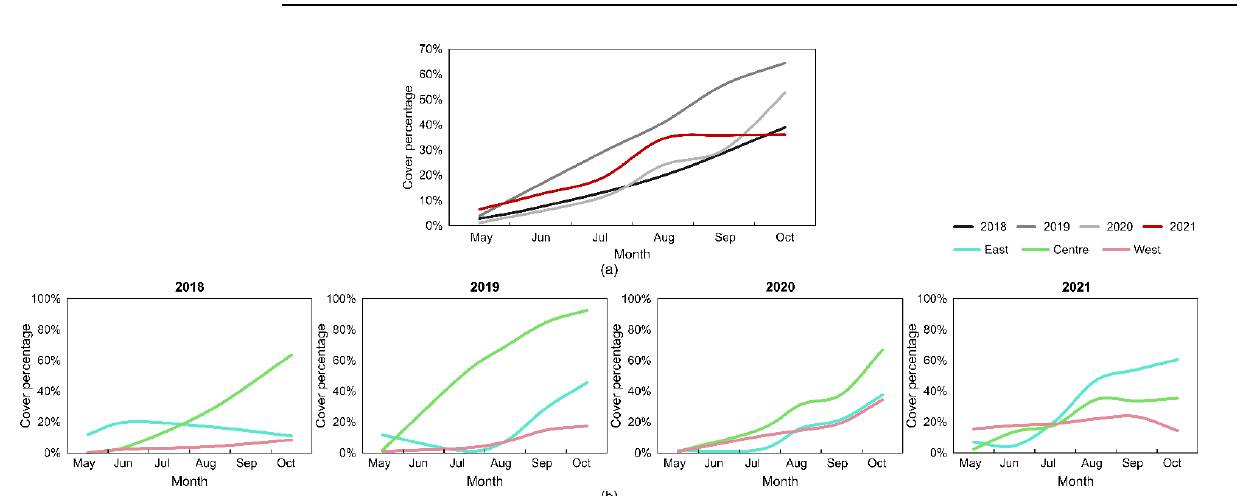
Figure 4. Water hyacinth temporal cover percentage evolution in each year, from May to October, for the whole study area ( a ) and in each analyzed water channel ( b ).